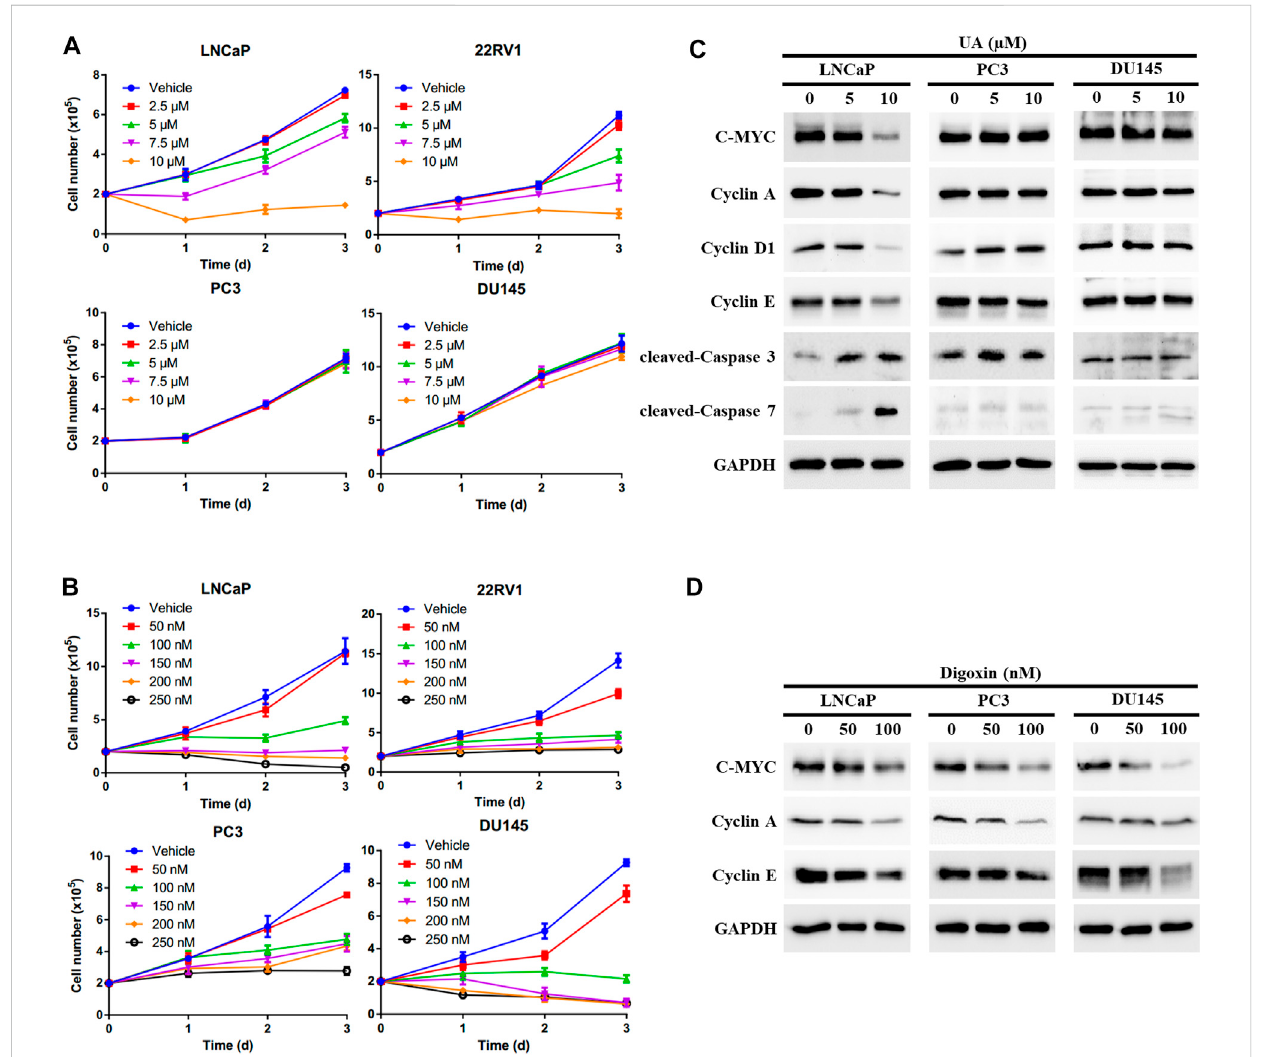
FIGURE 4 UA exhibits stronger inhibitory activity in AR-positive PCa compared with AR-negative PCa. ( A, B) AR-positive PCa cells (LNCaP and 22RV1) and AR- negative PCa cells (PC3 and DU145) were treated by UA (A) or digoxin (B) at indicated concentrations. One, two and 3 days later, viable cells